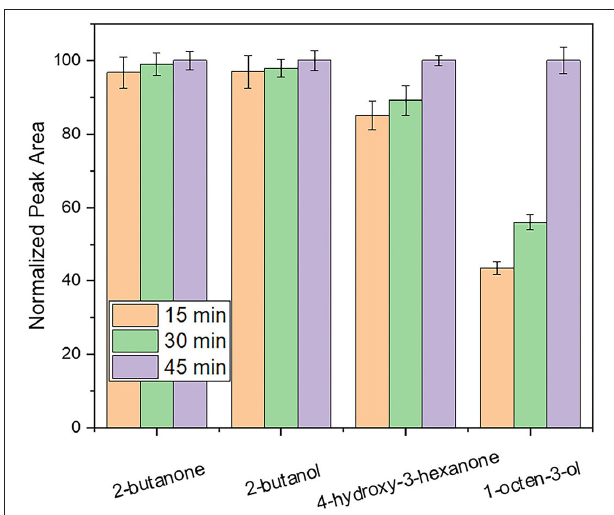
FIGURE 3 | Evaluation of the influence of extraction time on response using a desorption time of